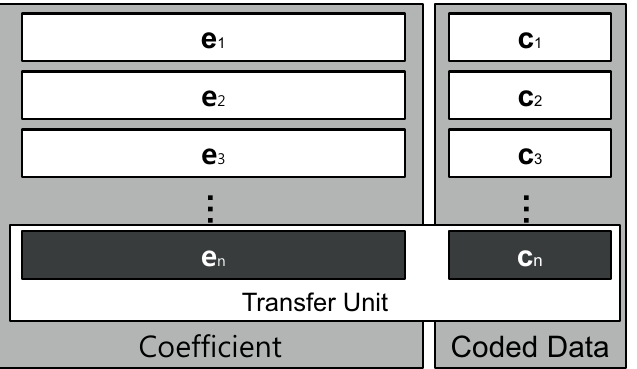
Figure 4. Data received at the receiving